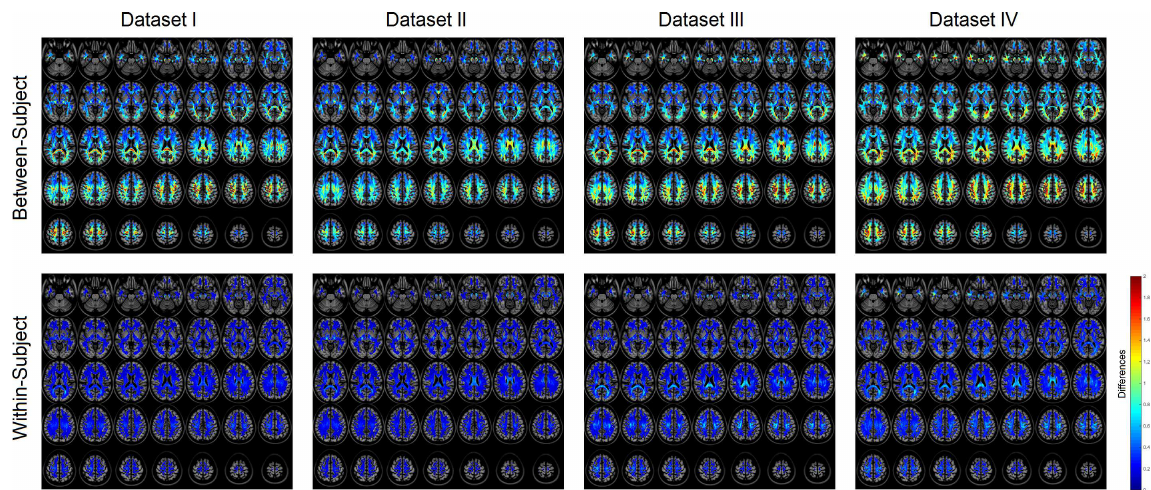
Fig 4. The spatial mapping of between-subject (first row) and within-subject (second row). Dataset I was acquiredwithin 16 days, whereas dataset II (1~3 months), dataset III (6 months) and dataset IV (a year) were acquired at longer time intervals. High between-subject differences can be observed in white matter tissue, especiallythe corpus callosum and central semiovale. The within-subject differences are much smaller, and repeat scans with longer time intervals show higher within-subject